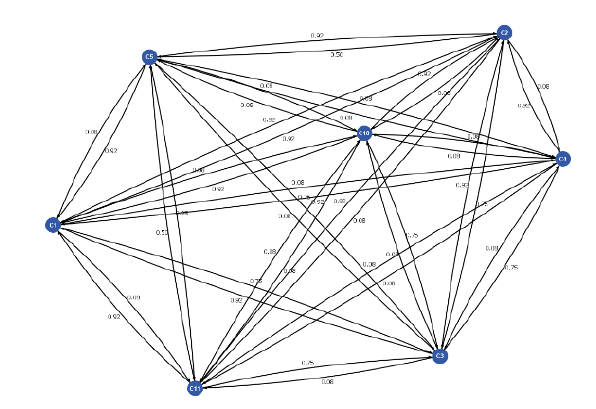
Fig. 5. Graphical representation of P&E factors of FCM.